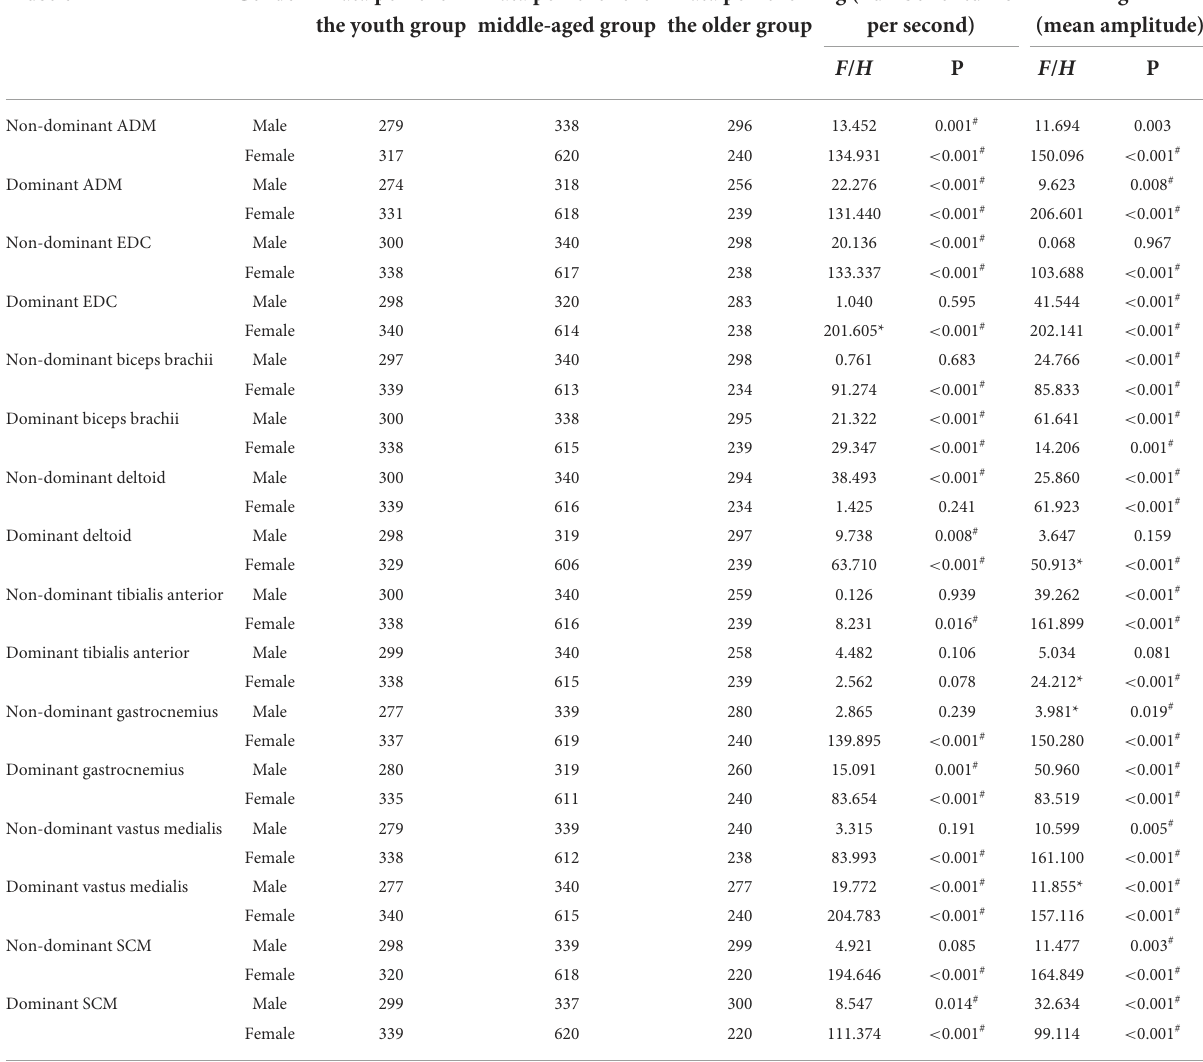
TABLE 4 The comparison of the results of lg (number of turns per second) and lg (mean amplitude) for different age groups. Muscle Gender Data point for Data point for the Data point for lg (number of turns lg the youth group middle-aged group the older group per second) (mean amplitude) F /